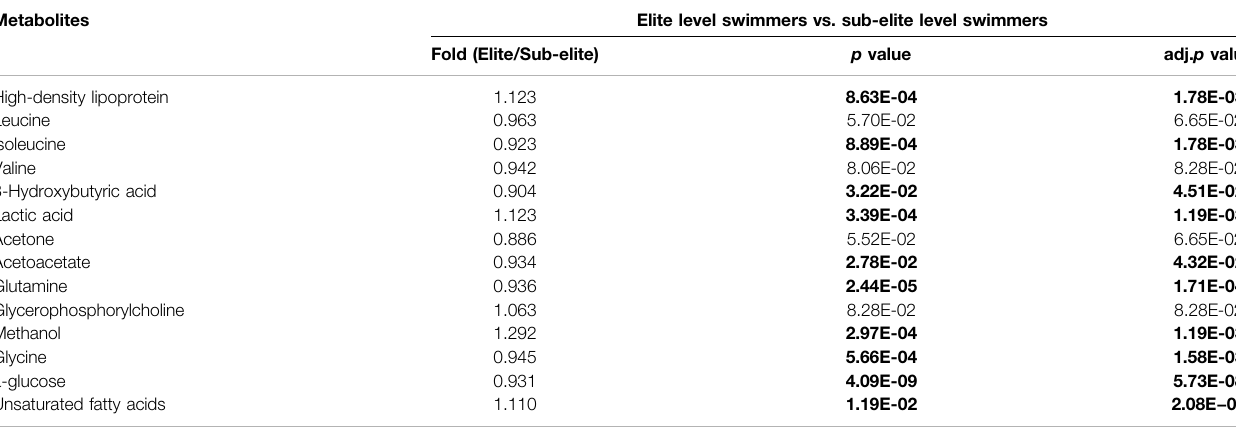
TABLE 2 | Serum metabolites with signi fi cant differences between elite and sub-elite level swimmers. Metabolites Elite level swimmers vs. sub-elite level swimmers Fold (Elite/Sub-elite) p value adj. p value High-density lipoprotein